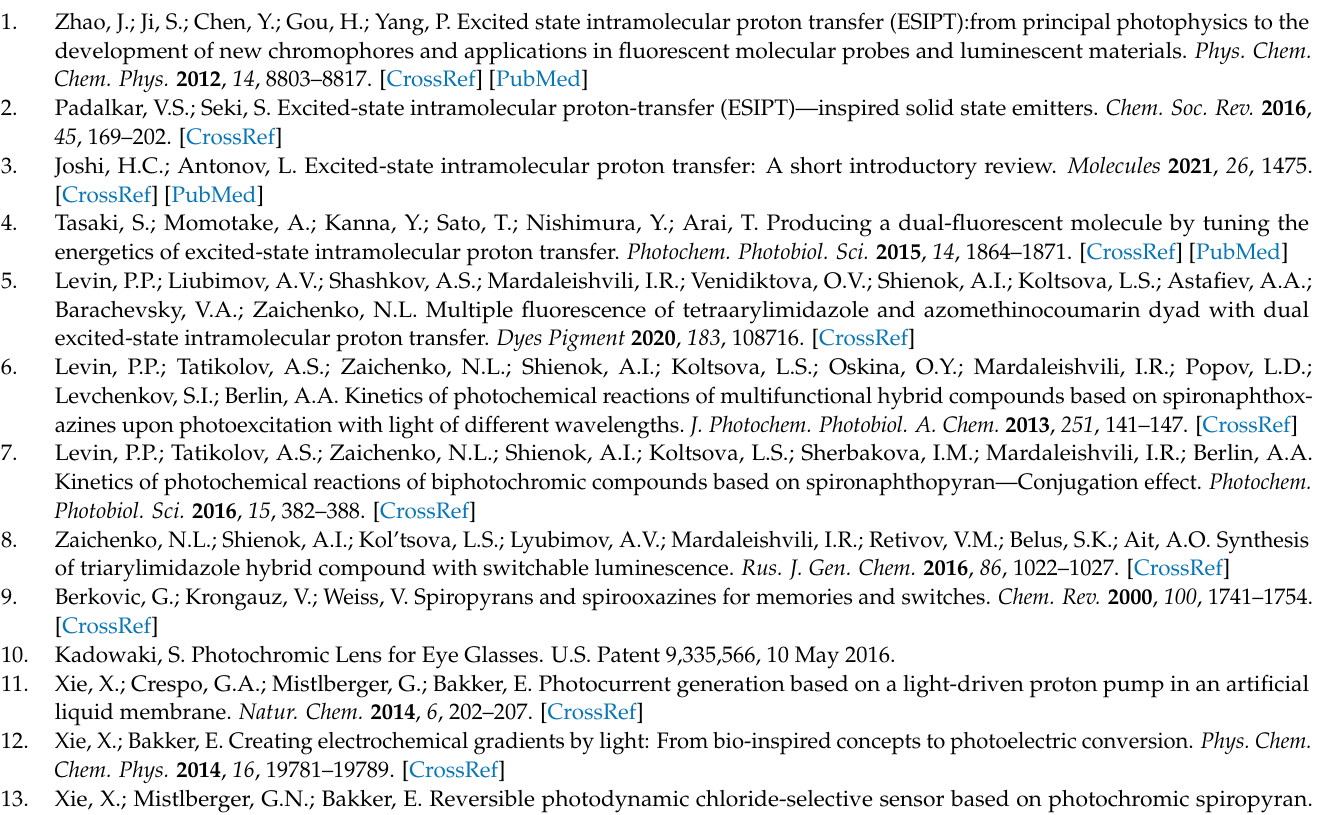
(1–4) and after UV irradiation (5–8) of compound 1 with Li + ions in the mixed toluene:acetonitrile solution, Figure S7: Absorption spectra (1, 5), fluorescence excitation spectra at λ reg = 545 nm (2, 6) and fluorescence at λ ex = 390 nm (3, 7) and 460 nm (4, 8) before (1.4) and after UV-irradiation of compound 1 with Ca 2+ ions in the mixed toluene:acetonitrile solution, Figure S8: Absorption spectra (1, 5), fluorescence excitation spectra at λ reg = 545 nm (2, 6) and fluorescence at λ ex = 390 nm (3, 7) and 480 nm (4, 8) before (1–4) and after UV-irradiation compound 1 with Zn 2+ ions in the mixed toluene:acetonitrile solution, Figure S9: The changes in the fluorescence emission spectra at 475 nm of compound 1 at Mg 2+